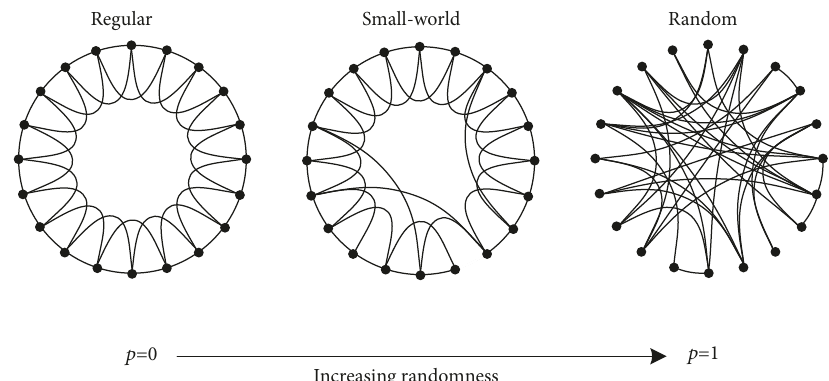
Figure 1: Construction process of the small-world network in the WS